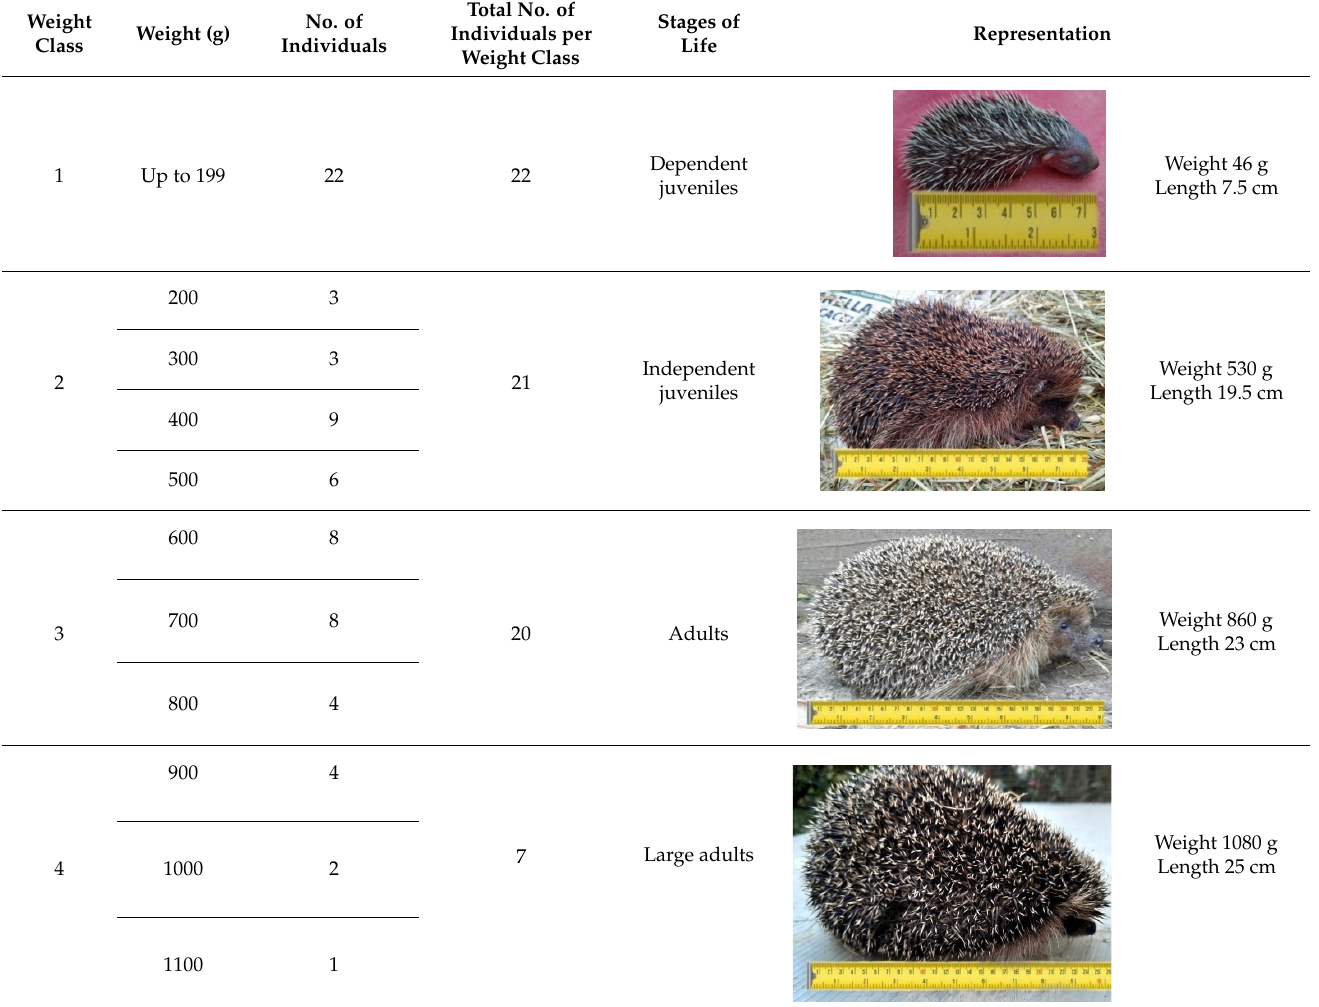
Table 2. Weight classes. Graphical representation of the four weight classes of dead hedgehogs used in the study. The pictures of live hedgehogs were provided to illustrate the sizes of individuals belonging to the four weight classes. No live hedgehogs were tested in this study. The ruler on the pictures indicates length of the individuals in cm. Photographs by Michela Dugar.